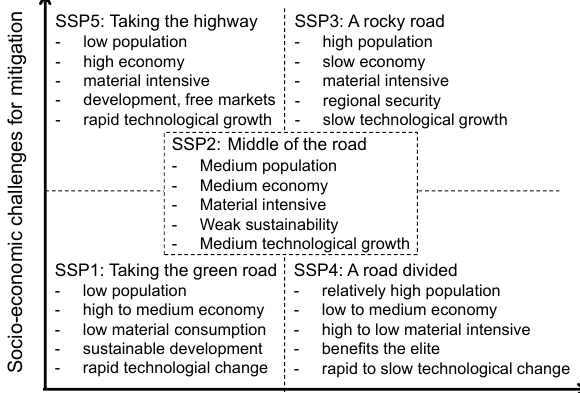
Figure 1. The SSP scenarios of global socio-economic develop- ment in the 21st century in their space of challenges for mitigation and adaption (adapted from O’Neill et al., 2013) and selected key elements: growth of population, growth of the economy, lifestyle, policy orientation and technological development (O’Neill et al.,